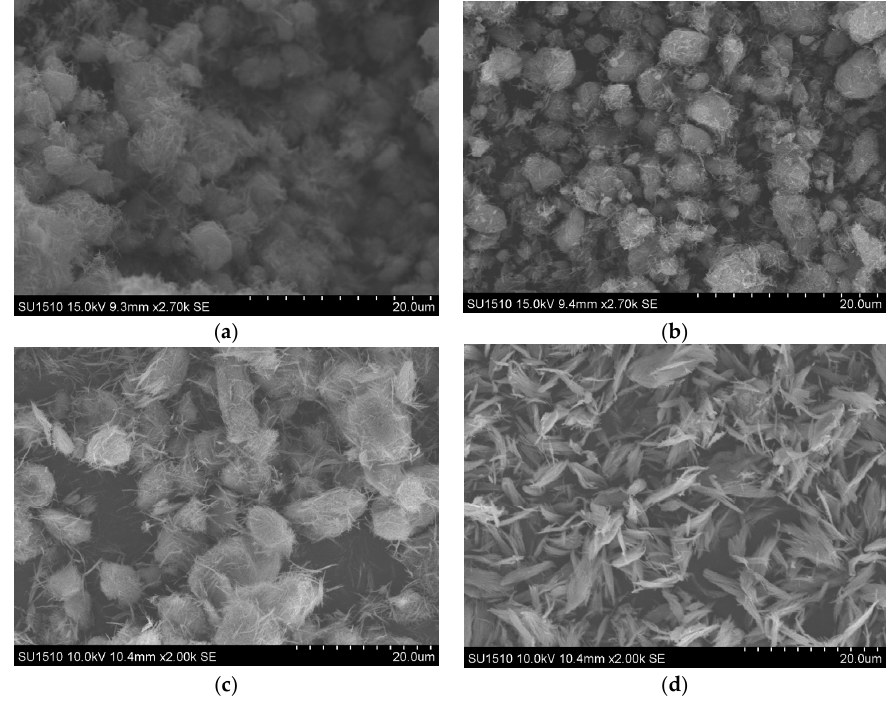
Figure 1. SEM images. K-OMS-2 ( a ); Cu-K-OMS-2-I ( b ); Cu-K-OMS-2-II ( c ); Cu-K-OMS-2-III ( d ).